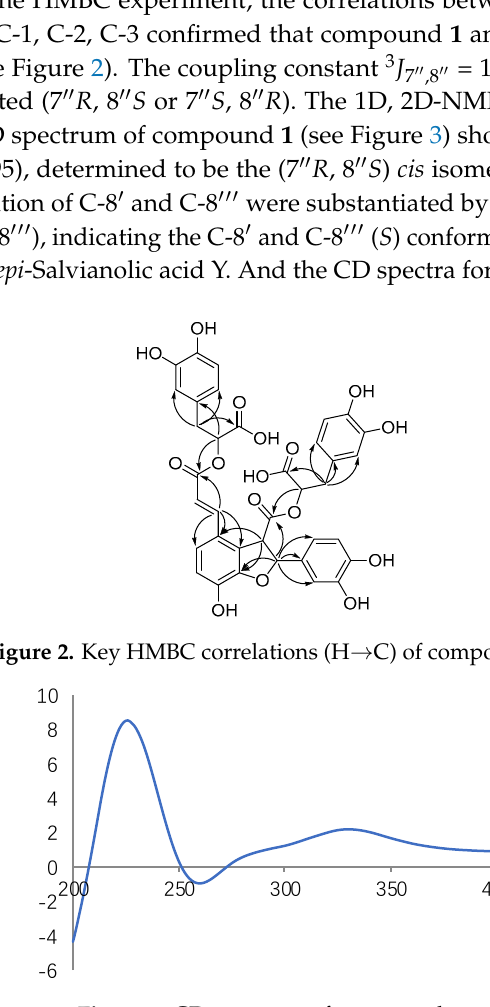
Figure 3. CD spectrum of compound 1 .